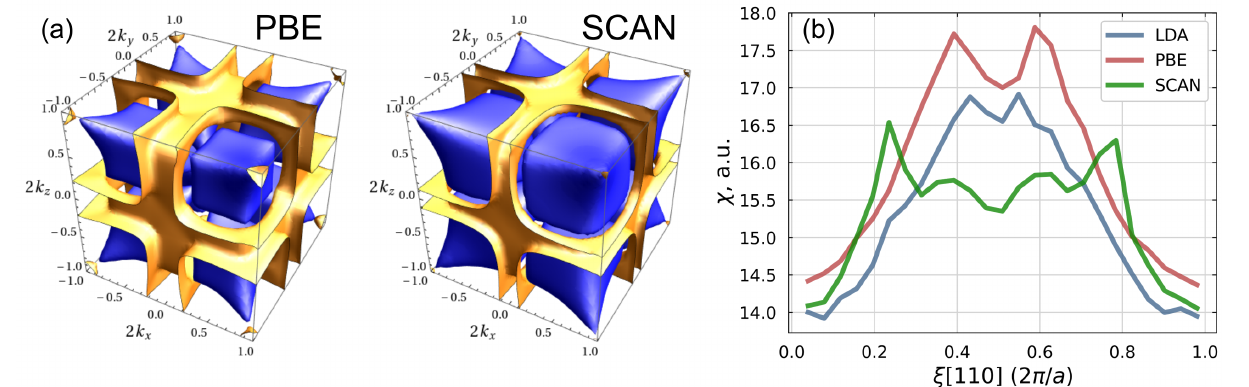
Figure 19. ( a ) Fermi surfaces of minority spin band of Ni 2 MnGa in the austenite phase. Blue (orange) corresponds to band 63 (64). ( b ) Cross-sections of the total generalized electron susceptibility along the [110] direction [105].